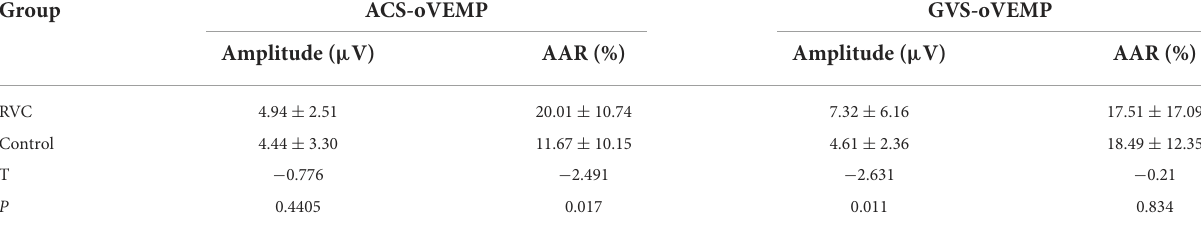
TABLE 6 Comparison of latencies and intervals of oVEMP between the RVC group and the control group.